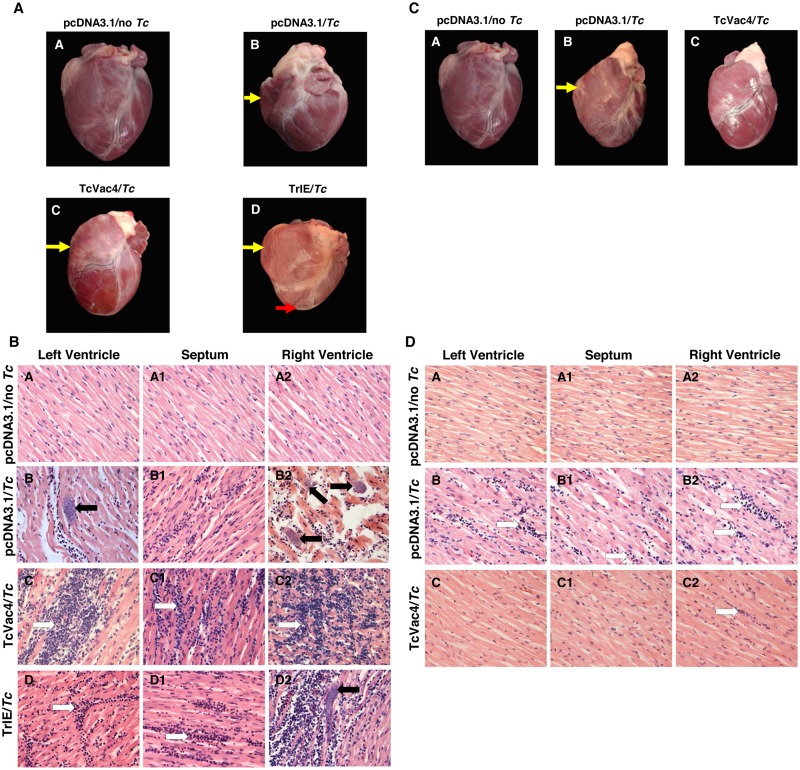
Macroscopic and microscopic alterations in the heart of T. cruzi-infected dogs (±TcVac4).
(A) Morphologic alterations of heart in acute infection phase (±TcVac4). Shown are representative heart pictures from dogs included in pcDNA3.1/no Tc (A), pcDNA3.1/Tc (B), TcVac4/Tc (C) and TrIE/Tc (D) groups, harvested at day 60 pi. Yellow arrows indicate right ventricular dilation. Red arrows indicate the pale/striated areas of fibrotic tissue. (B) Histological analysis of heart tissue-sections in acutely-infected dogs (±TcVac4). Heart tissue sections (5-μM) from left ventricle, septum, and right ventricle were obtained at 60 days pi, and stained with hematoxylin-eosin. Shown are representative micrographs of heart from dogs injected with pcDNA3.1/Tc (B, B1, B2), TcVac4/Tc (C, C1, C2), and TrIE/Tc (D, D1, D2). Micrographs from pcDNA3.1/no Tc (A, A1, A2) are shown as negative controls. Black arrows show amastigotes nests. White arrows show inflammatory infiltrate in the myocardium. (C) Morphologic alterations of heart in chronic disease phase (±TcVac4). Shown are representative heart pictures from dogs included in pcDNA3.1/no Tc (A), pcDNA3.1/Tc (B), TcVac4/Tc (C) and TrIE/Tc (D) groups, harvested at day 365 pi. Black arrows point out the right ventricular dilation. (D) Histological analysis of heart tissue-sections in chronically-infected dogs (±TcVac4). Heart tissue sections (5-μm) from left ventricle, septum, and right ventricle were obtained at 365 days pi, and stained with hematoxylin-eosin. Shown are representative micrographs of chronically-infected dogs injected with pcDNA3.1 only (B, B1, B2) or immunized with TcVac4 (C, C1, C2). Micrographs from pcDNA3.1/no Tc, i.e. normal/healthy controls (A, A1, A2) are shown for comparison. White arrows mark infiltrating inflammatory cells in myocardium.